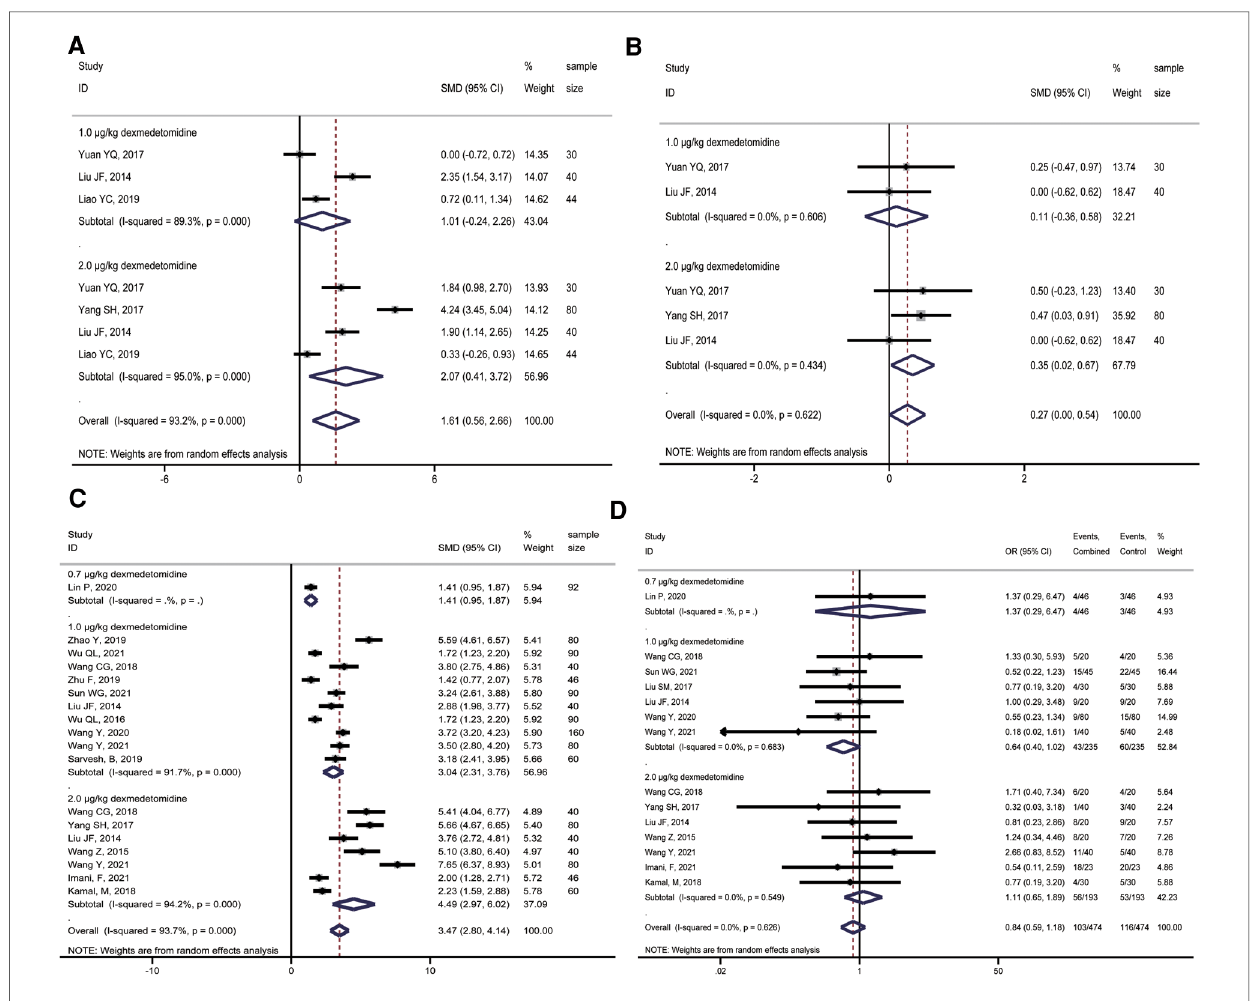
FIGURE 5 Forest plot of comparison of combined group and control group: ( A ) Ramsay score at 12 h (T 4 ); ( B ) Ramsay score at 24 h (T5); ( C ) First postoperative analgesic supplementation time; ( D ) Incidence of postoperative adverse effects.